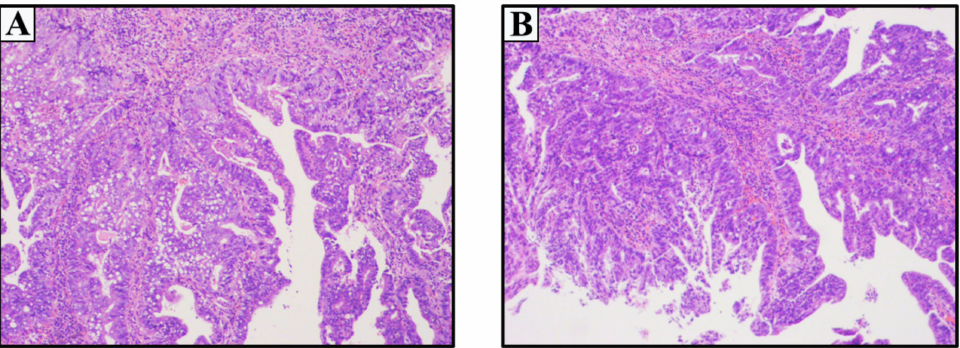
Figure 1. Primary female urethral adenocarcinoma of the Case 1 (4 × 10 magnification). ( A ) Post- biopsy pathology. ( B ) Postoperative routine